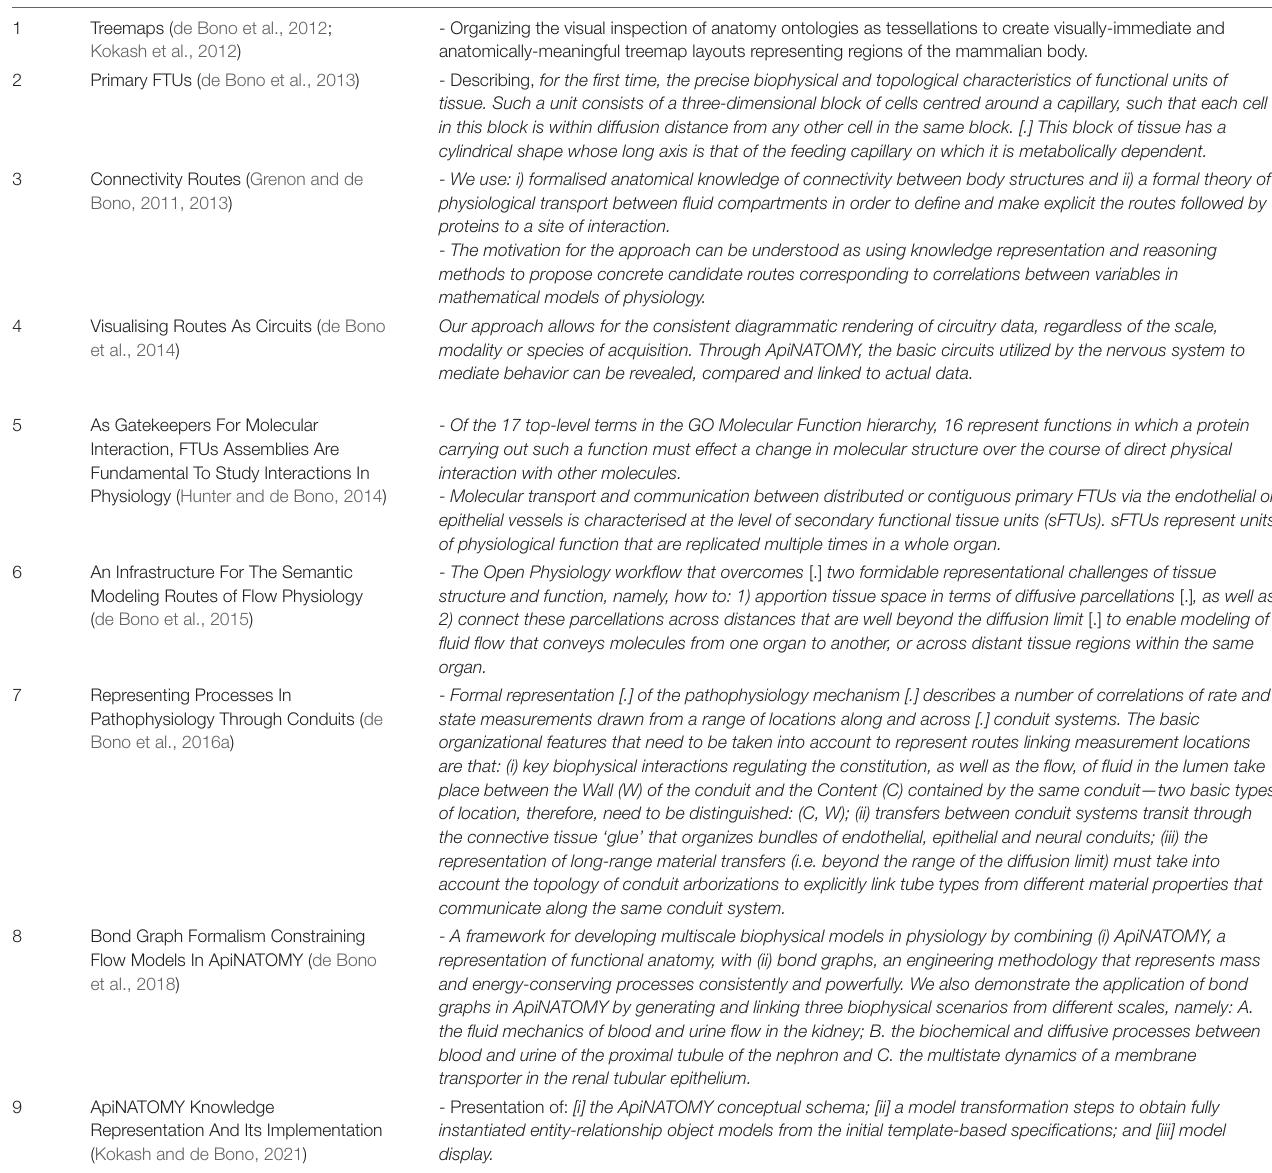
TABLE 1 | Timeline for milestones in ApiNATOMY